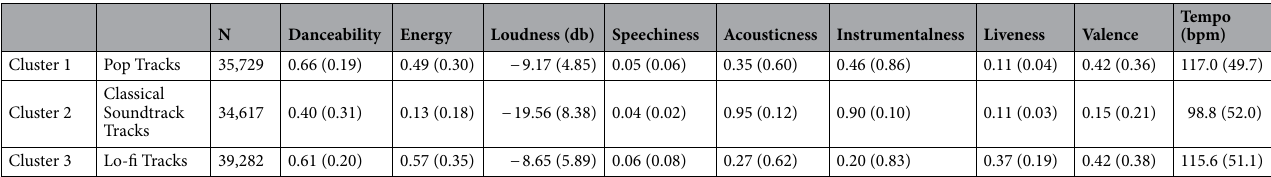
Table 4. Medians and interquartile ranges of all audio features for the 3 clusters of the Study dataset.